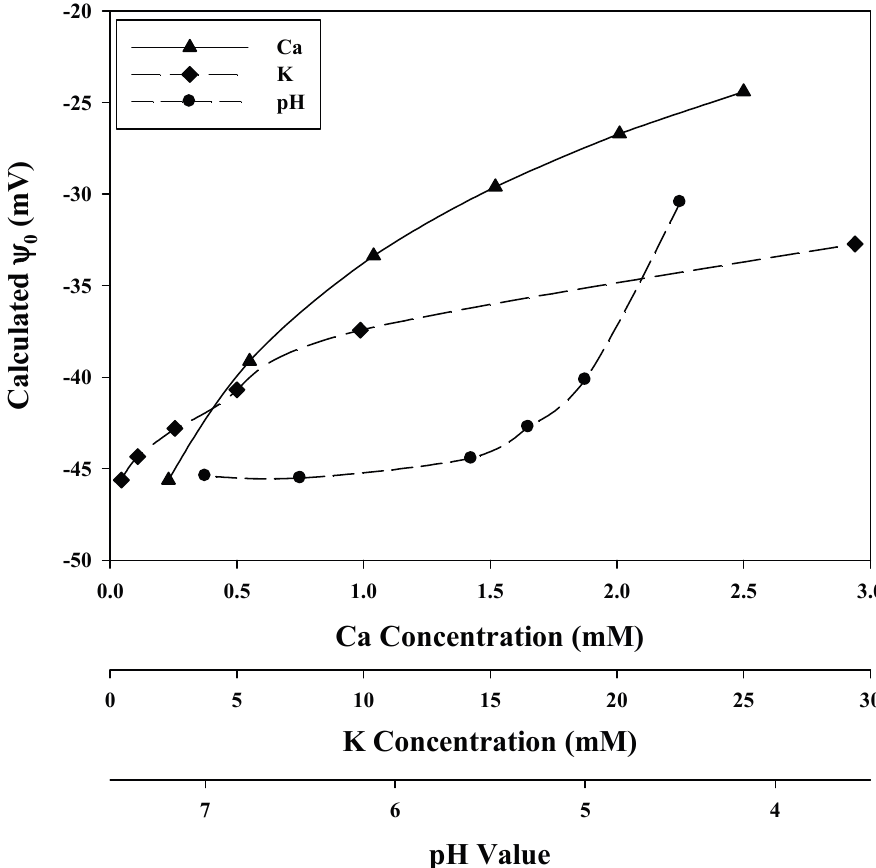
Figure 2. Responses of root cell plasma membrane (PM) surface electrical potential ( ψ 0 ) to increasing concentrations of Ca 2+ , K + , and H + in the cell-bathing media, which contain a background of 0.23 mM Ca 2+ , 0.22 mM Mg 2+ , 0.97 mM Na + , 0.44 mM K + and pH = 6.0. These ψ 0 values were calculated by the Gouy-Chapman-Stern (GCS) model. Data were obtained from Wang et al.